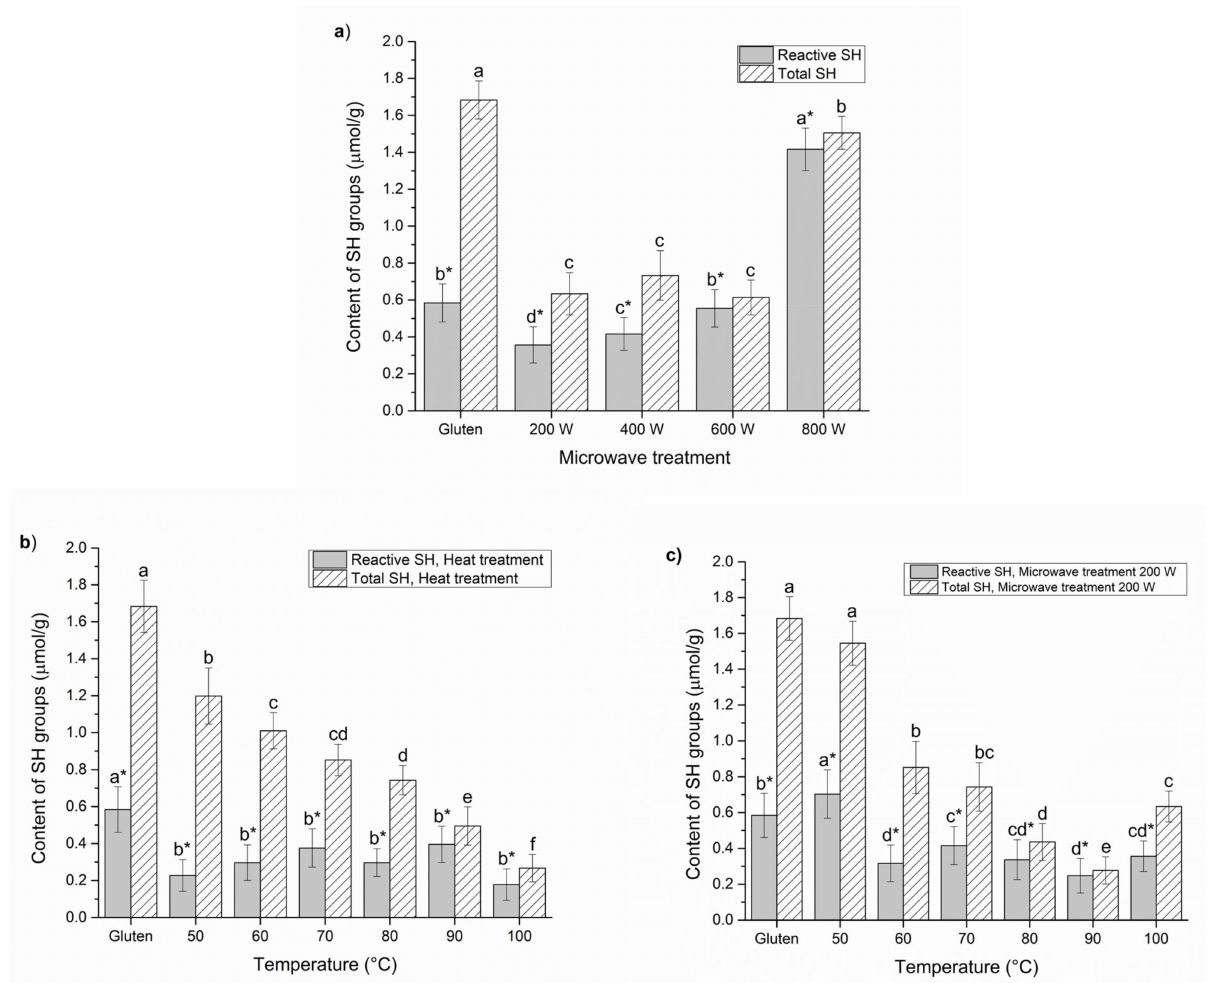
Figure 4. Content of total and reactive SH groups detected after: ( a ) microwave treatment of wheat gluten at different powers (200–800 W); ( b ) heat treatment of wheat gluten at different temperatures (50–100 ◦ C); and ( c ) microwave treatment of wheat gluten at 200 W and controlled different temperatures (50–100 ◦ C). All measurements were compared at the same protein concentration 2 mg/mL. Results are expressed as mean ± standard deviation (n = 3). Means with different letters in the same figure are significantly different ( p <